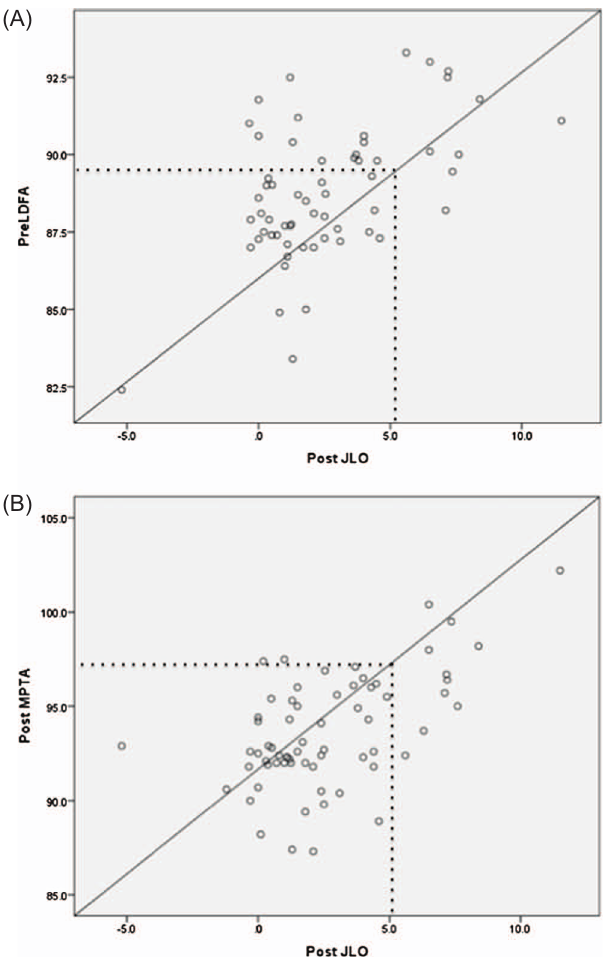
Figure 3. The correlations between post-operative JLO and pre- and post-operative radiological parameters. (A) The correlations between post-operative JLO and pre-operative LDFA. 5 (cid:1) of postoperative JLO corresponds to a preoperative LDFA of 90 (cid:1) (dotted line). (B) The correlations between post-operative JLO and post-operative MPTA. 5 (cid:1) of postoperative JLO corresponds to a postoperative MPTA of 97.5 (cid:1) (dotted